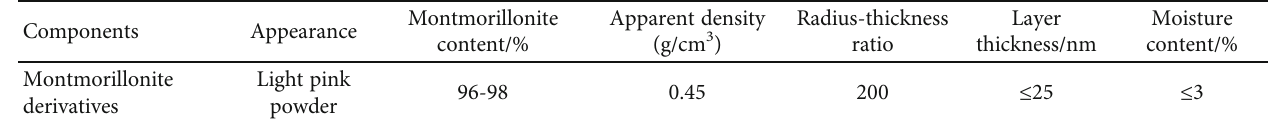
Table 3: Technical indexes of nanoclay.